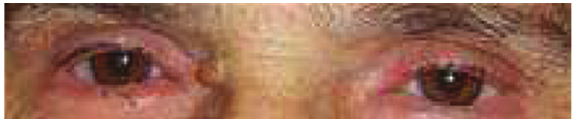
Figure 4: Chronic conjunctivitis with blepharitis aspects.